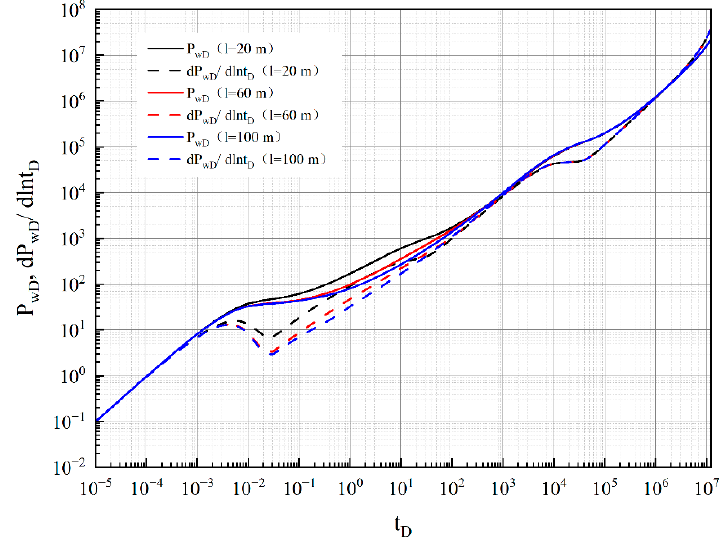
Figure 11. The effect of the FSRV half-width on the pressure response.